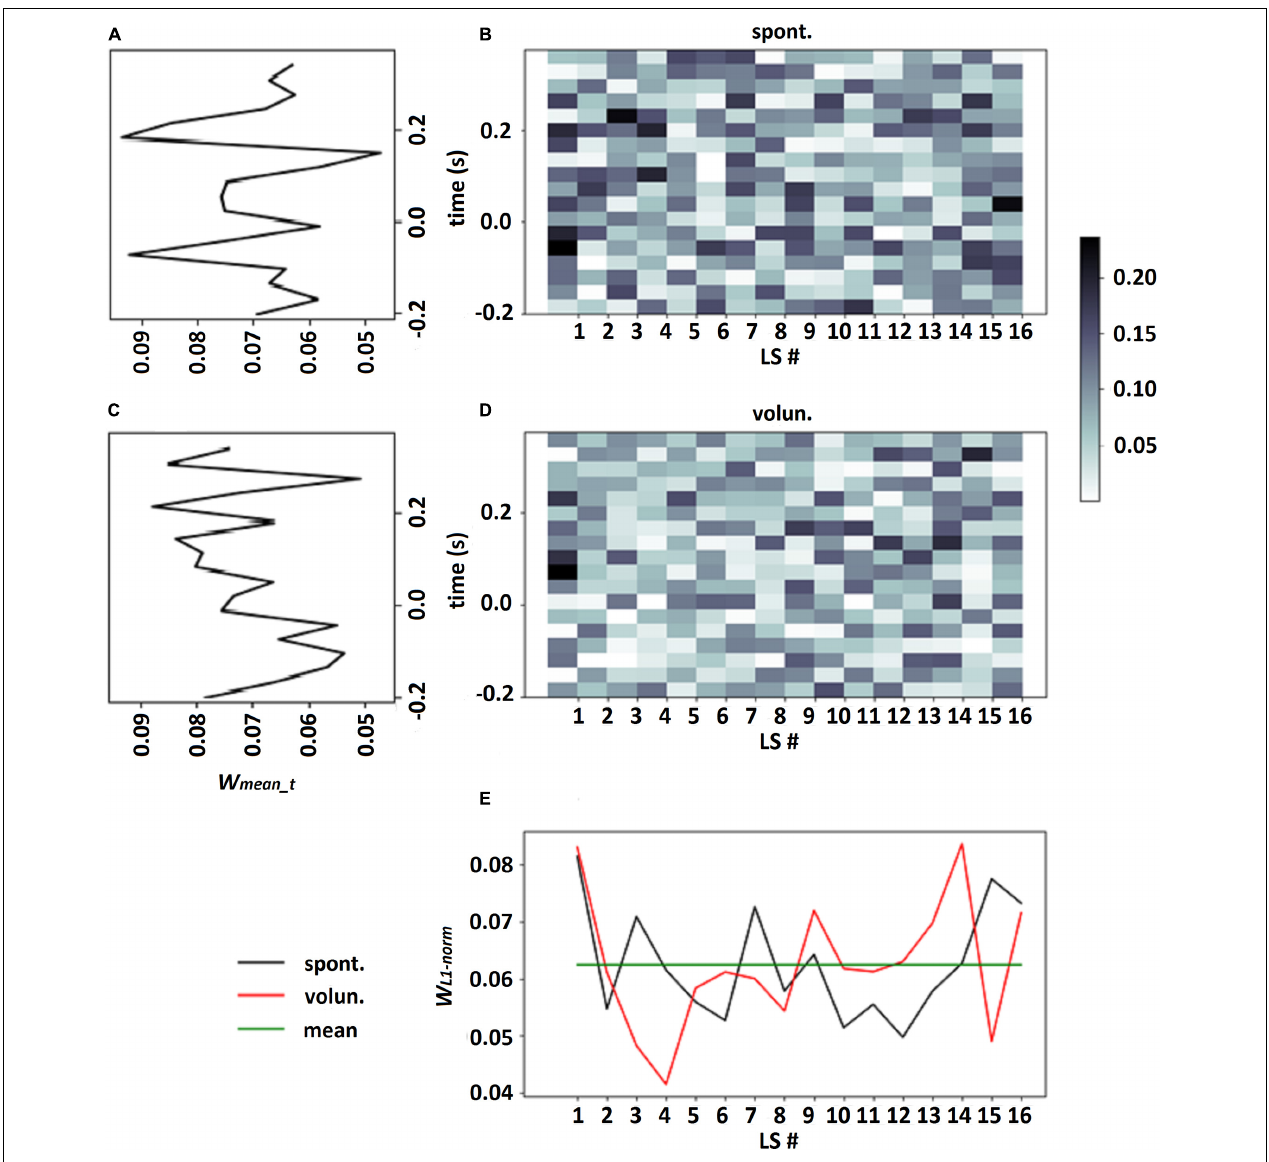
FIGURE 3 | Output weights of LF-CNN learned on participant 114 data for spontaneous and voluntary classes ( B,D , respectively), LS weights for each class according to eq. 4, where proportion of the L1-norm of output weights over time points in the total sum of L1-norms of all LSs (E) , averaged weights in every time point over all LSs for spontaneous and voluntary classes ( A,C ,